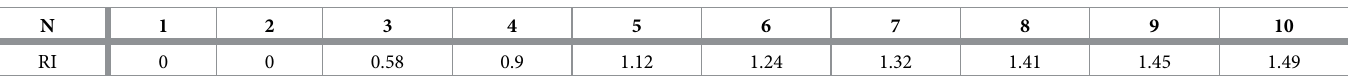
The calculation of CR is given by Eq 2, using the values of RI and the numerical scale. Table 1. Random consistency